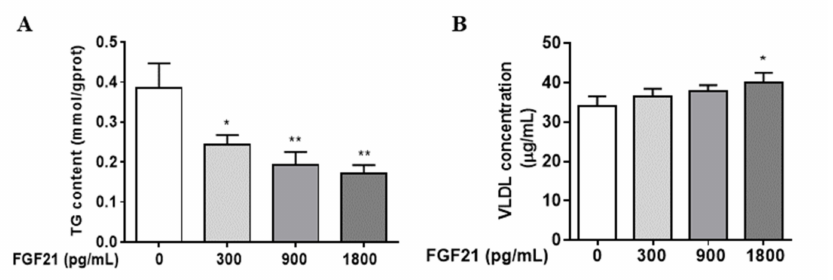
Figure 1. FGF21 stimulates hepatocellular VLDL secretion, resulting in the reduction in intracellular TG content. The content of intracellular TG ( A ) and extracellular VLDL ( B ) were detected after being treated with different concentrations of FGF21 for 24 h in primary hepatocyte. Three independent experiments were performed. Statistically significance was indicated: *, p < 0.05; **, p < 0.01, * was compared with control group.